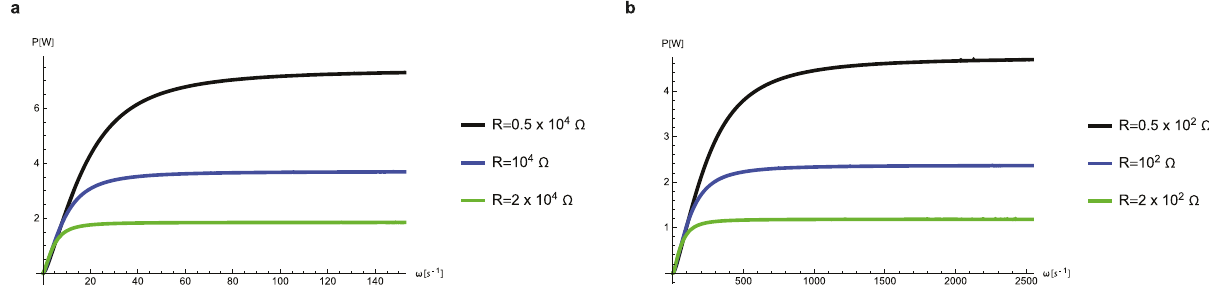
Fig. 8 Average power pro fi le as a function of rotational frequency for different loads. Curves are plotted for: a PC with N ¼ 10 2 stages and priming voltage V ref ¼ 50V; b IL with N ¼ 10 3 stages and priming voltage V ref ¼ 4V. And, again, the parameter domains are different for a and b ; the arguments for this are explained in the caption of Fig.